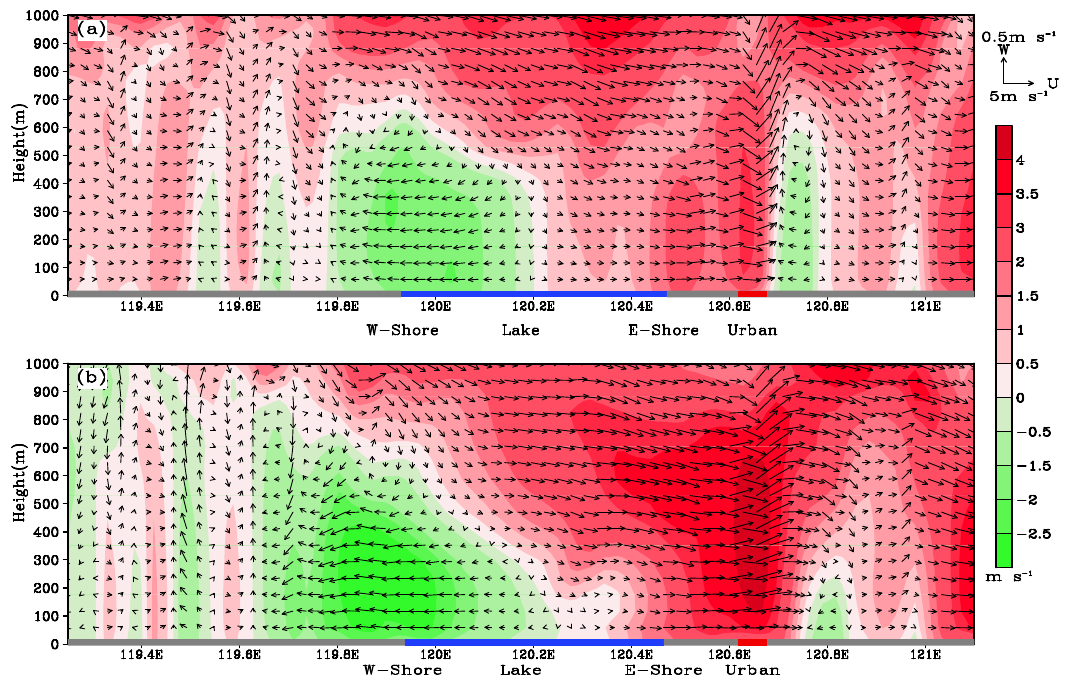
Figure 10. Cross section of wind vector along the center latitude (31.2 o N) at 14:00 19 July 2012 by ( a ) S_lake; ( b ) D-Lake.